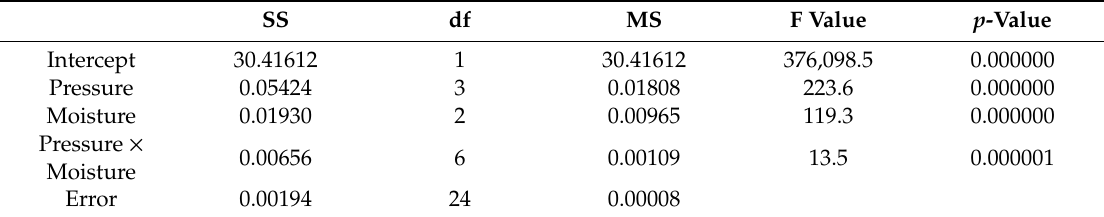
Table 4. Two-way ANOVA—DE.